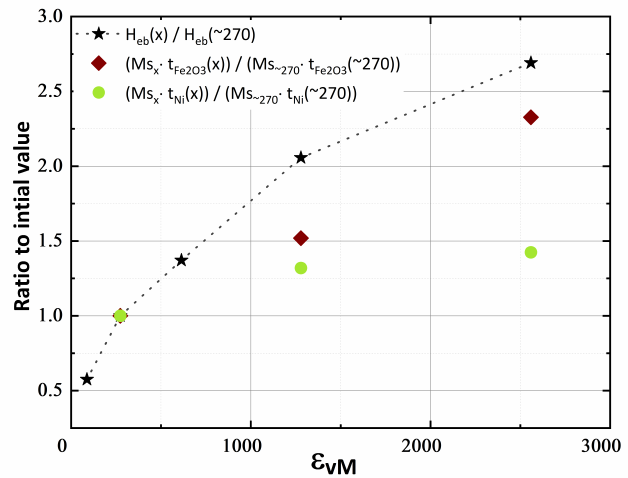
Figure 7. Relative change of H eb related to H eb, (cid:101) changes of M S and CSDS size of t γ -Fe